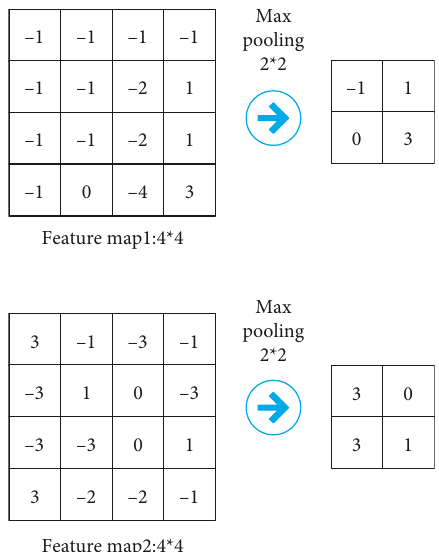
Figure 8: Maximum pooling operation